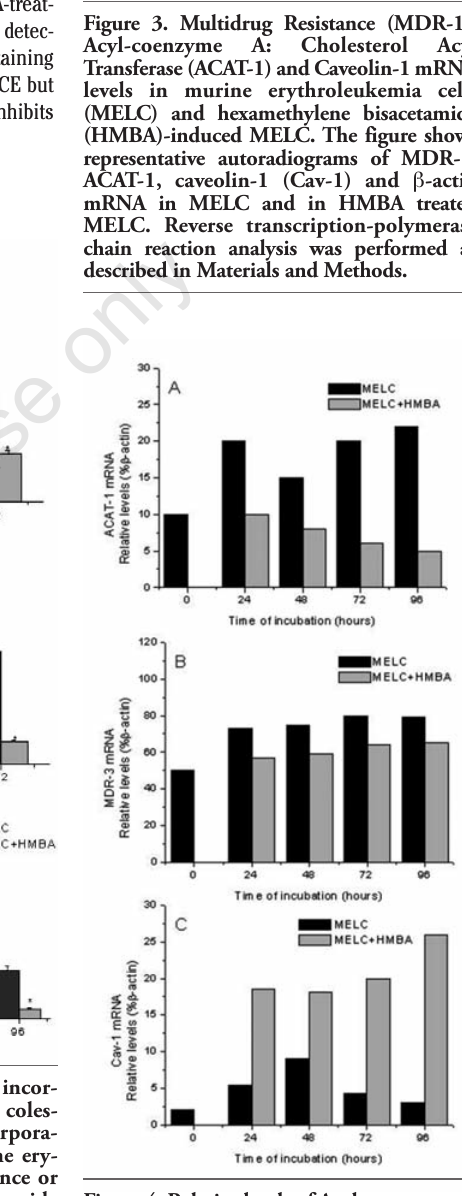
Figure 4. Relative levels of Acyl-coenzyme A: Cholesterol AcylTransferase (ACAT-1), Multidrug Resistance (MDR-3) and Caveolin-1 (C) mRNA in murine ery- throleukemia cells (MELC). Reverse tran- scription-polymerase chain reaction analysis was performed for three independent exper- iments. Relative levels of A) ACAT-1, B) MDR-3 and C) Caveolin-1 (Cav-1) mRNA were normalized to the corresponding β - actin levels and expressed as